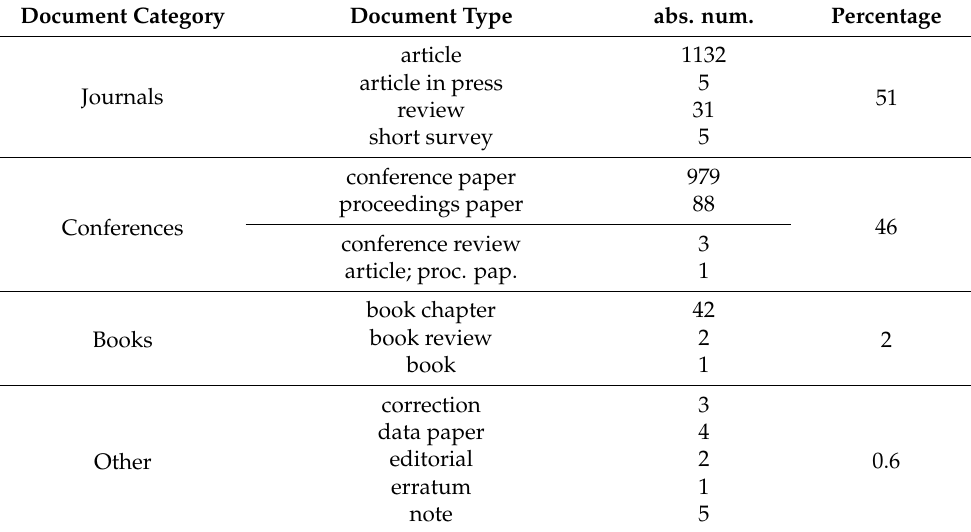
Table 1. Documents of the OSM dataset (total documents = 2337).